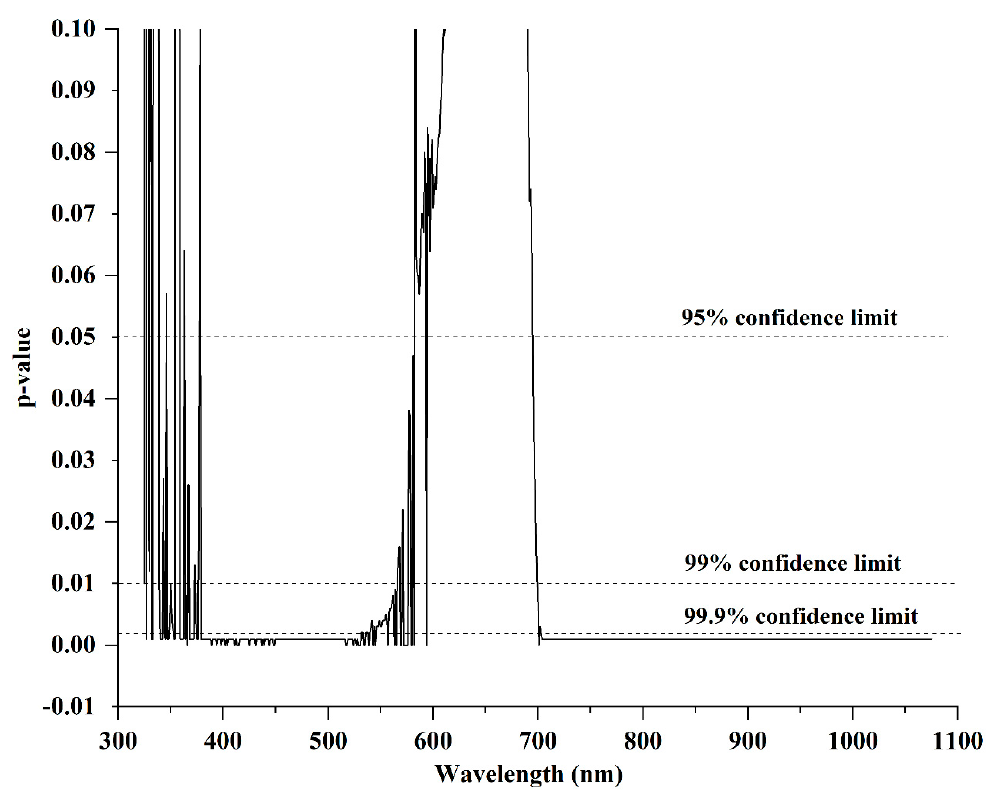
Figure 8. Significance value plot of the ANOVA test. The p -value shows that the mean reflectance of all species at every spectral band ( n = 562) is significantly different ( p < 0.05). The graphical representation of the ANOVA outcomes showed that most of the regions of leaf spectra were statistically different for all plant species (Figure 9). Most of the red-edge and NIR regions were able to show spectral differences among all plant species. The reflectance curves at blue wavelengths in the visible region also showed significant differences ( p < 0.05). However, it was evident that 189 wavelength bands located in red and red-edge regions had statistically non-significant ANOVA ( p > 0.05) results (Figure 8), indicating that these regions (582–699 nm) were similar in reflectance among all plant species (Figure 9).